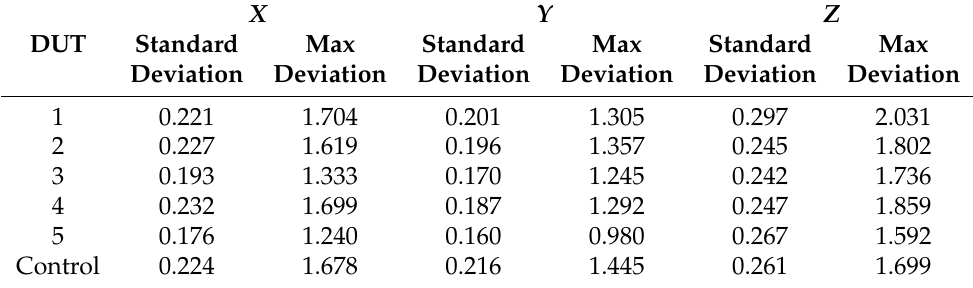
Table 4. Noise for each DUT and axis during the 10th hour of the cool start test